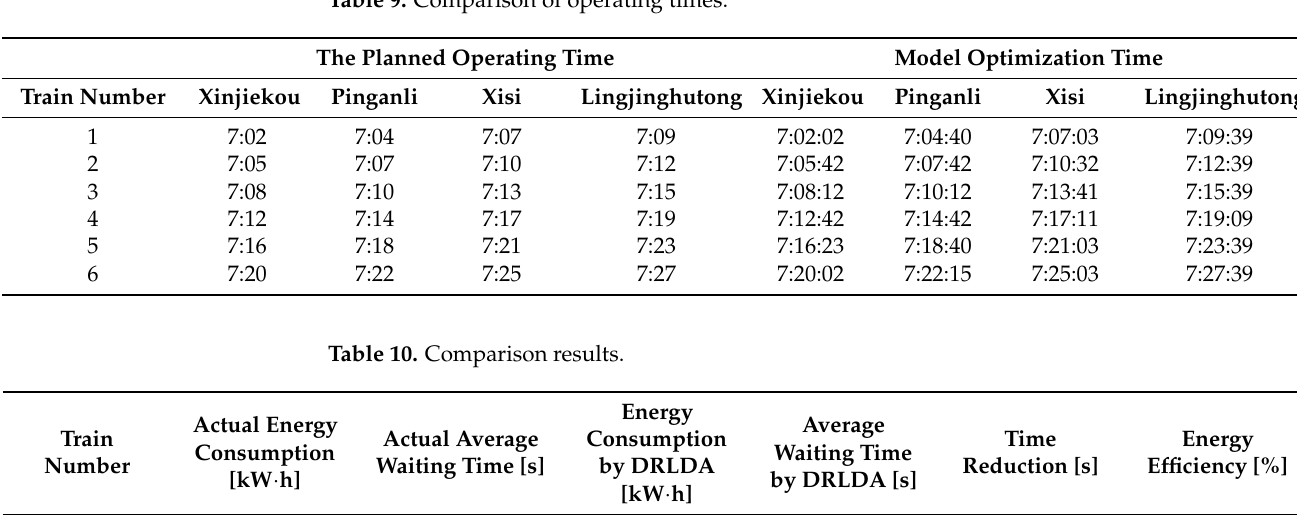
Table 10. Comparison results.